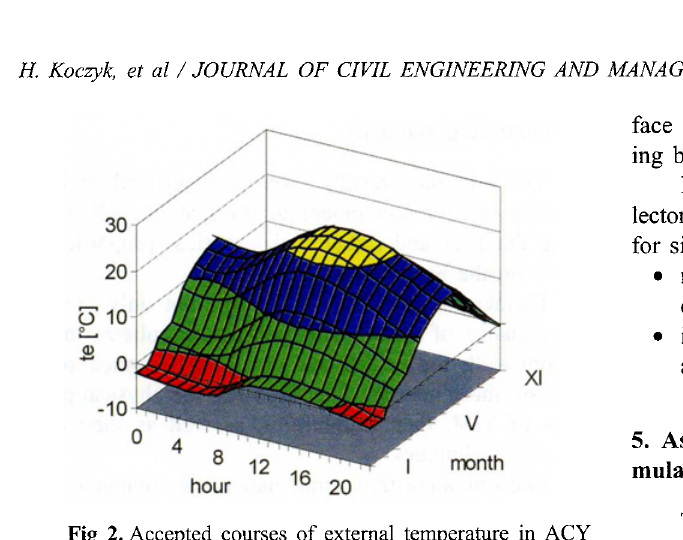
Fig 2. Accepted courses of external temperature in ACY of Poznan and courses of diffuse radiation are presented in Fig 4.